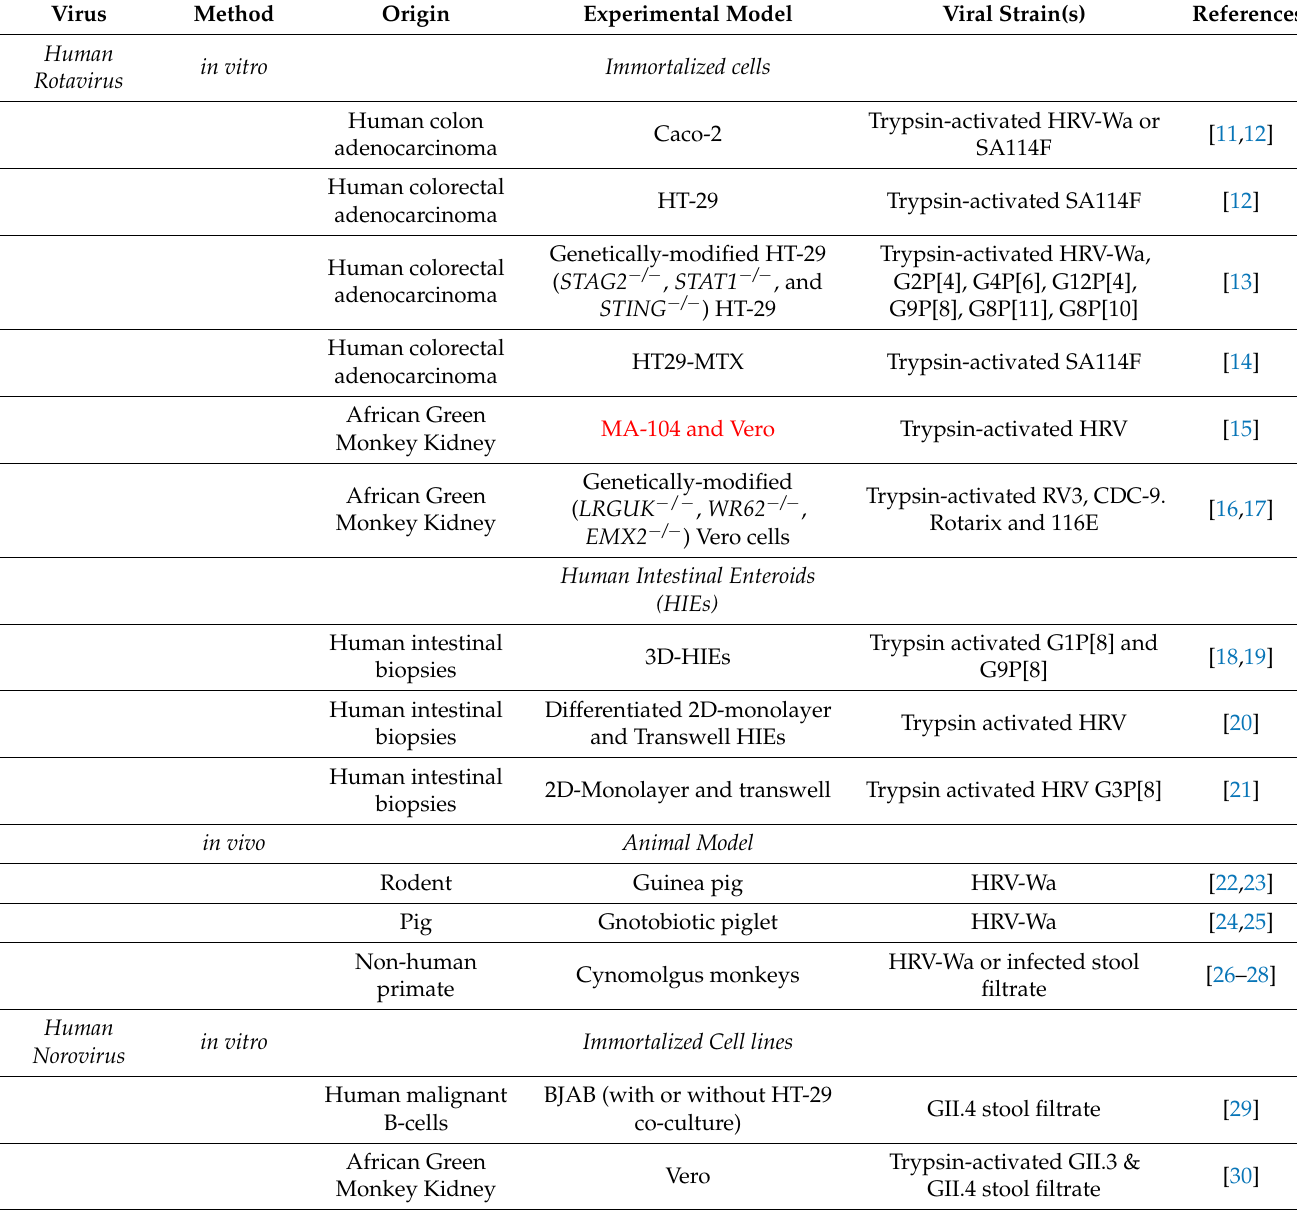
Table 1. Summary of commonly employed in vitro and in vivo models to study human rotavirus, norovirus, and astrovirus, with most broadly-used approaches shown in